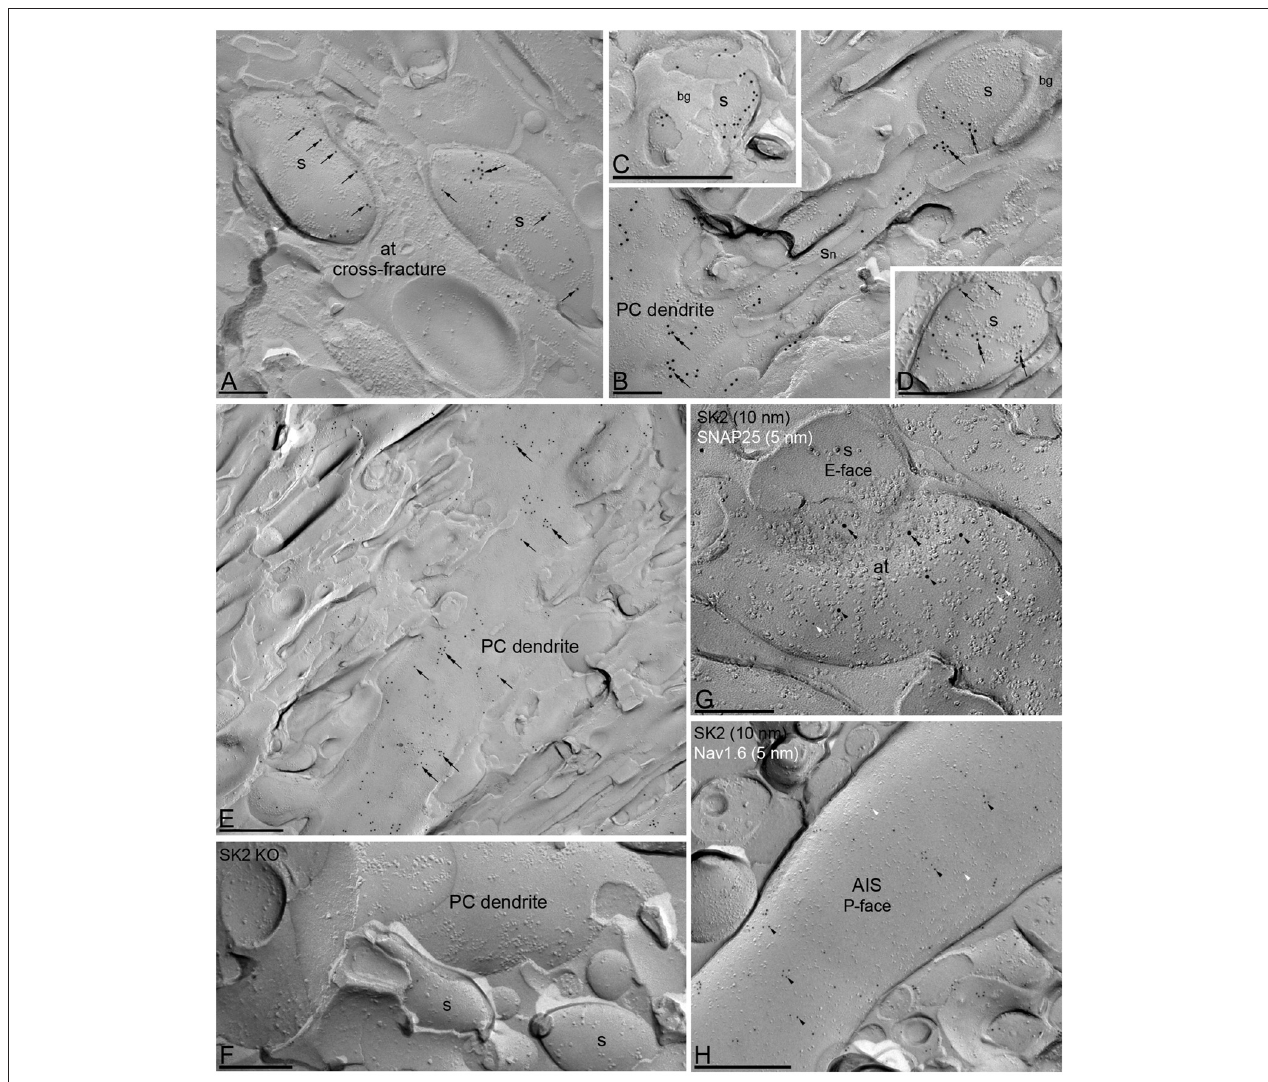
FIGURE 1 | Subcellular localization of SK2 channels along the surface of Purkinje cells (PCs) using the SDS-digested freeze-fracture replica labeling (SDS-FRL) technique. Immunolabeling is restricted to the plasma membrane P-face of PCs. The E-face of Bergmann glia (bg), cross-fractures (panel A ) or E-faces of neurons (panel G ) are free of any immunolabeling. (A–E) Immunoparticles for SK2 channels (10 nm gold) are scattered (arrows) and clustered (double arrows) in dendritic spines (S) and dendritic shafts (PC dendrite, DEN) of PCs. (G) The image shows a high-magnification of the replicated plasma membrane of an axon terminal (at), presumably from granule cells, and spines (s) in a E-face view, showing the co-localization of SK2 (10 nm immunogold) and SNAP25 (5 nm immunogold, white arrowheads). Within this presynaptic localization, SK2 immunoparticles were observed both along the active zone (AZ; double black arrowheads) and at extrasynaptic membranes (black arrowheads). (H) The image shows the P-face of an axon initial segment (AIS) co-labeled for the SK2 (10 nm, black arrowheads) and Nav1.6 (5 nm, white arrowheads) channels. Very low frequency of immunogold labeling for SK2 was detected along AIS. (F) The specificity of the antibody was confirmed in replicas of SK2 channel-knockout mice (SK2 KO) that were free of any immunolabeling. Scale bar: (A,D,F,G) 0.2 µ m; (E,H) 0.5 µ